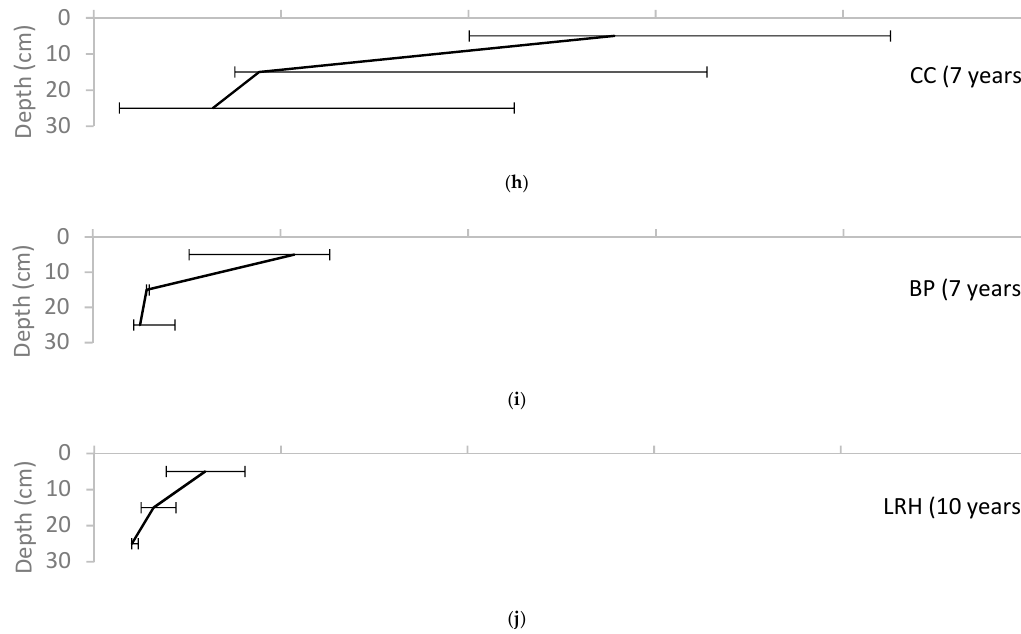
Figure 3. Variation of soil organic matter with depth for each of the field sites, reported as median ± range. ( a ) UMCP; ( b ) WNY; ( c ) MJES; ( d ) CBF; ( e ) NWHS; ( f ) PP; ( g ) CF; ( h ) CC; ( i ) BP; ( j ) LRH.